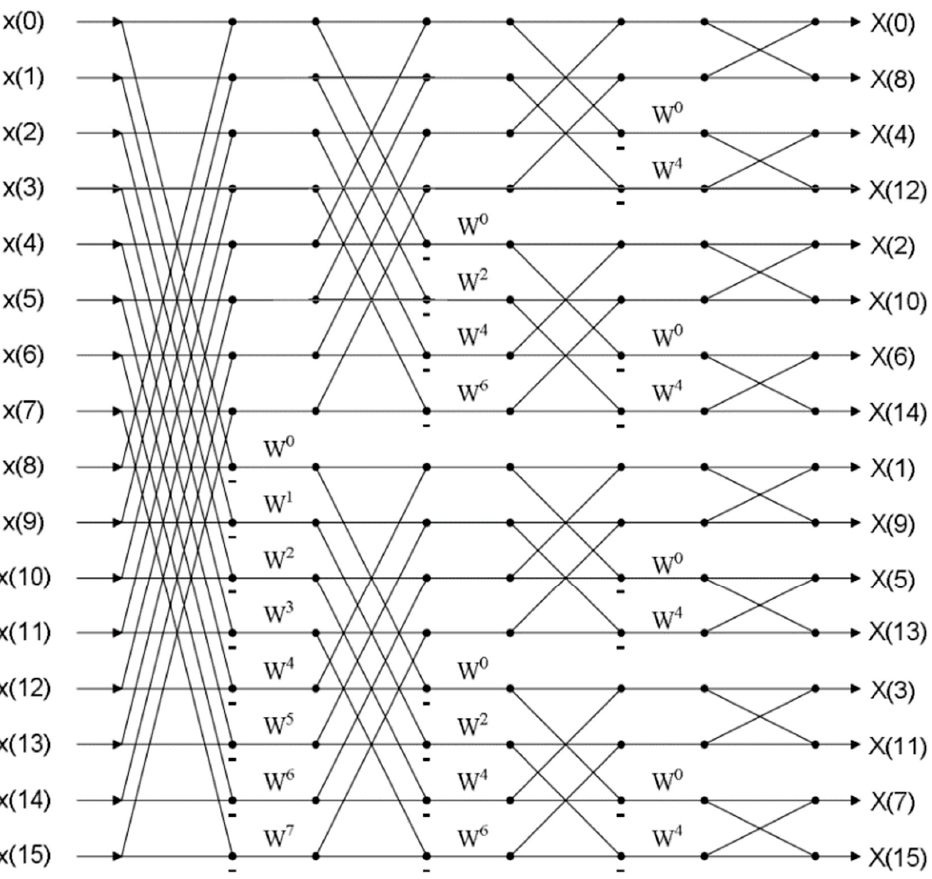
Figure 2. The signal flow graph of a 16-point fast Fourier transform (FFT) on the radix-2 decimation in frequency (R2DIF) algorithm.